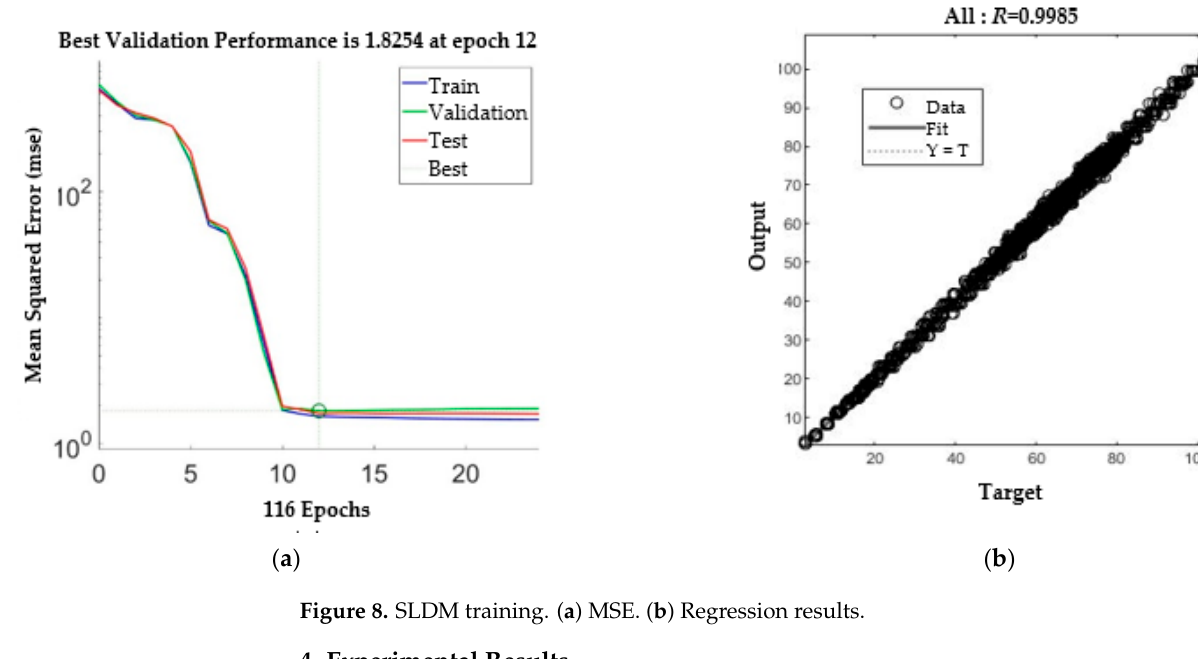
Figure 7. ANN-based SLDM for drilling simulation.